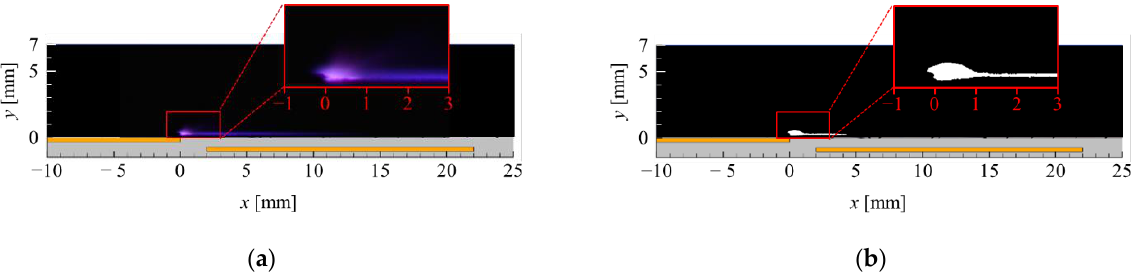
Figure 7. Photograph of the discharge emission of the plate-PA. An enlarged view of the area around the discharge is shown in a red frame: ( a ) row image; ( b ) binarized image.